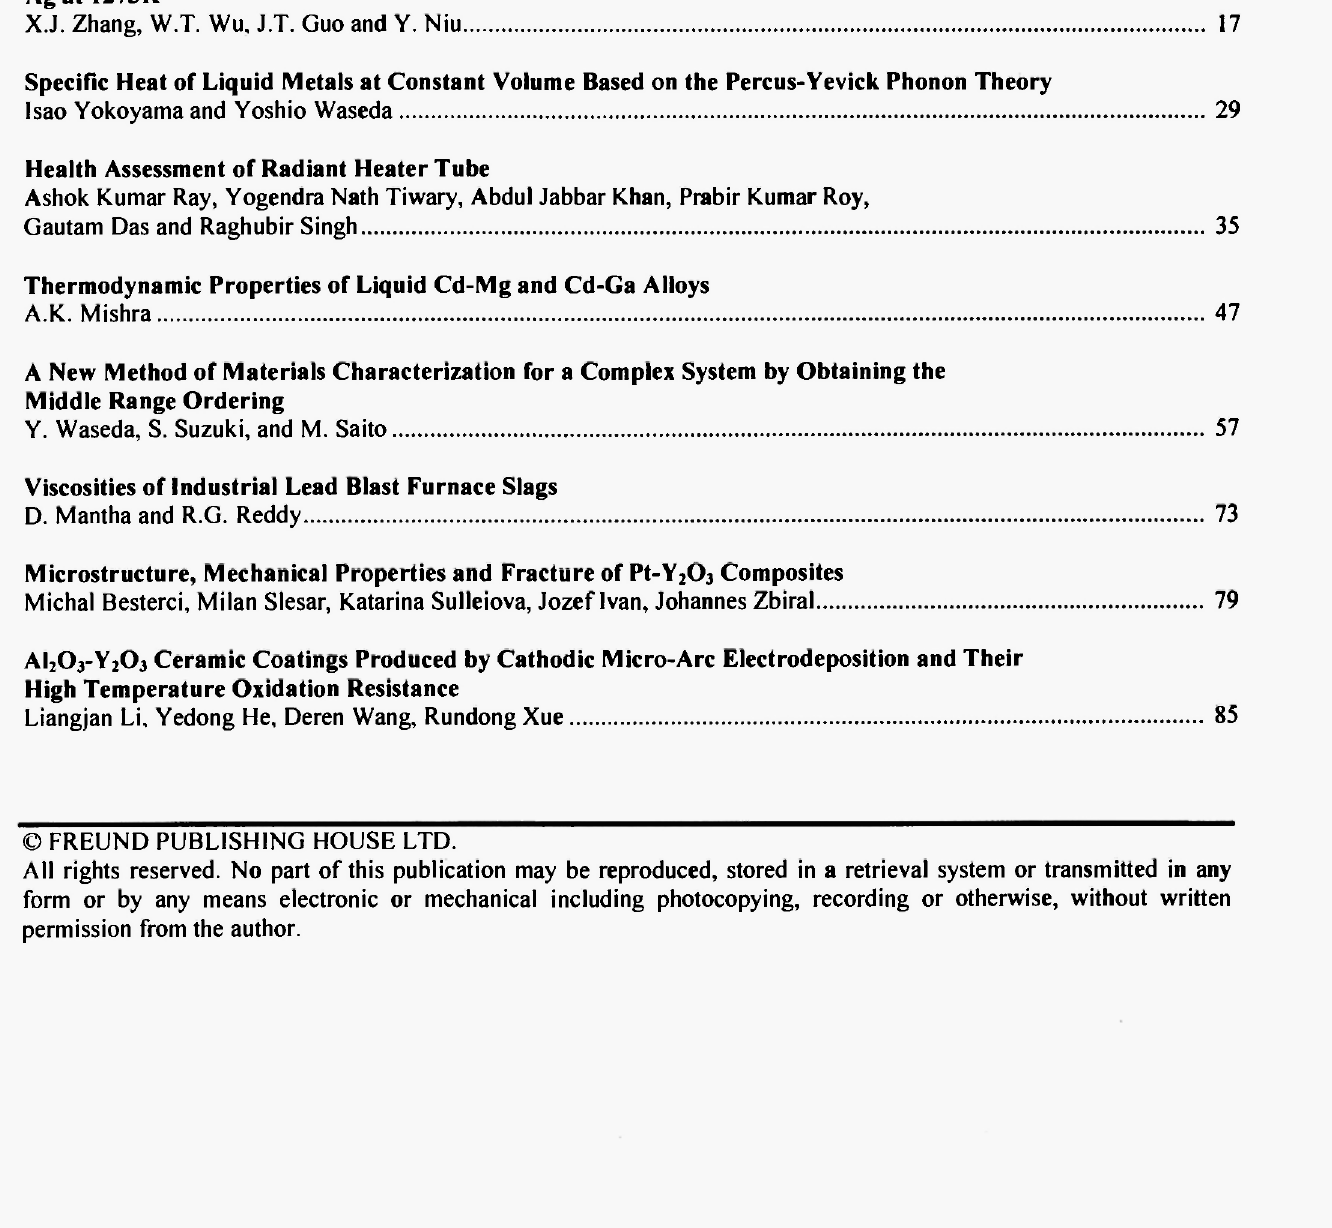
Preparation of Niobium-Aluminium Alloys by Aluminothermic Reduction of Nb 2 O s J.M. Juneja Carbothermic Reduction of Zircon Under Reduced Pressure